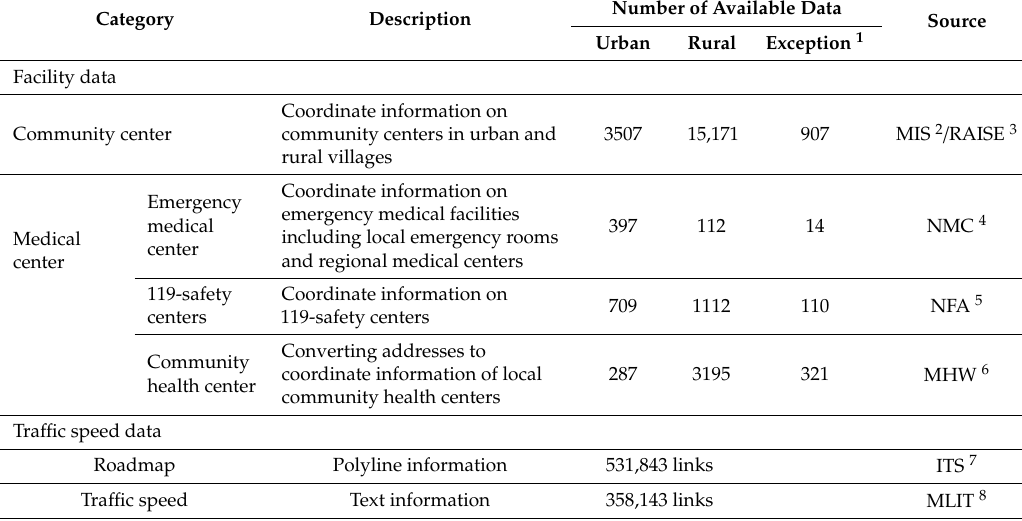
Table 1. List of available data (facility, population, and tra ffi c speed data) to analyze the vulnerable areas for emergency medical services (EMS). The facility data include data about community centers and medical centers. Each type of data includes a description of the data, the number of available statistics (urban and rural), and reasons for exceptions. The data were provided by the Korean government, and the source of each type of data is